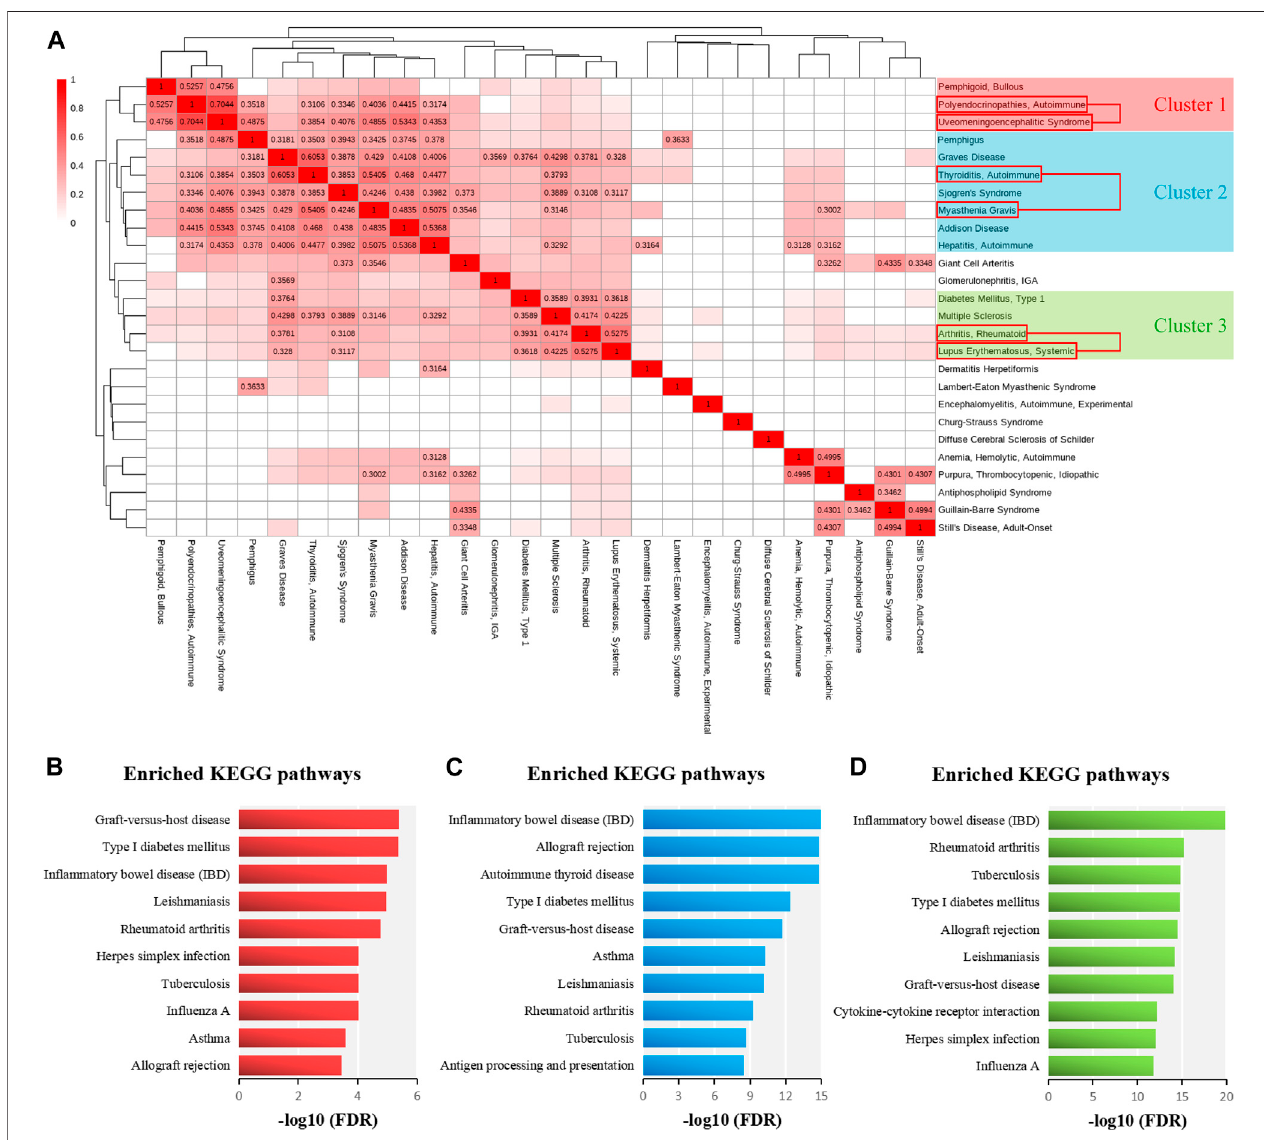
FIGURE6| Clusteranalysisfor26ADsandpathwayenrichmentanalysisforADsofeachsigni fi cantcluster. (A) Theclusteringheatmapillustratingtheclassi fi cation of 26ADs based on Euclidean distances and integrated similarity scoresbetween26 ADs. The similarity values, which aregreaterthan 0.3, are marked in thematrix. (B) Thetoptensigni fi cantKEGGpathwaysofrelatedgenesofADsofclusteronerankedby – log10(FDR). (C) Thetoptensigni fi cantKEGGpathwaysofrelatedgenesofADs of cluster two ranked by – log10 (FDR). (D) The top ten signi fi cant KEGG pathways of related genes of ADs of cluster three ranked by – log10 (FDR).